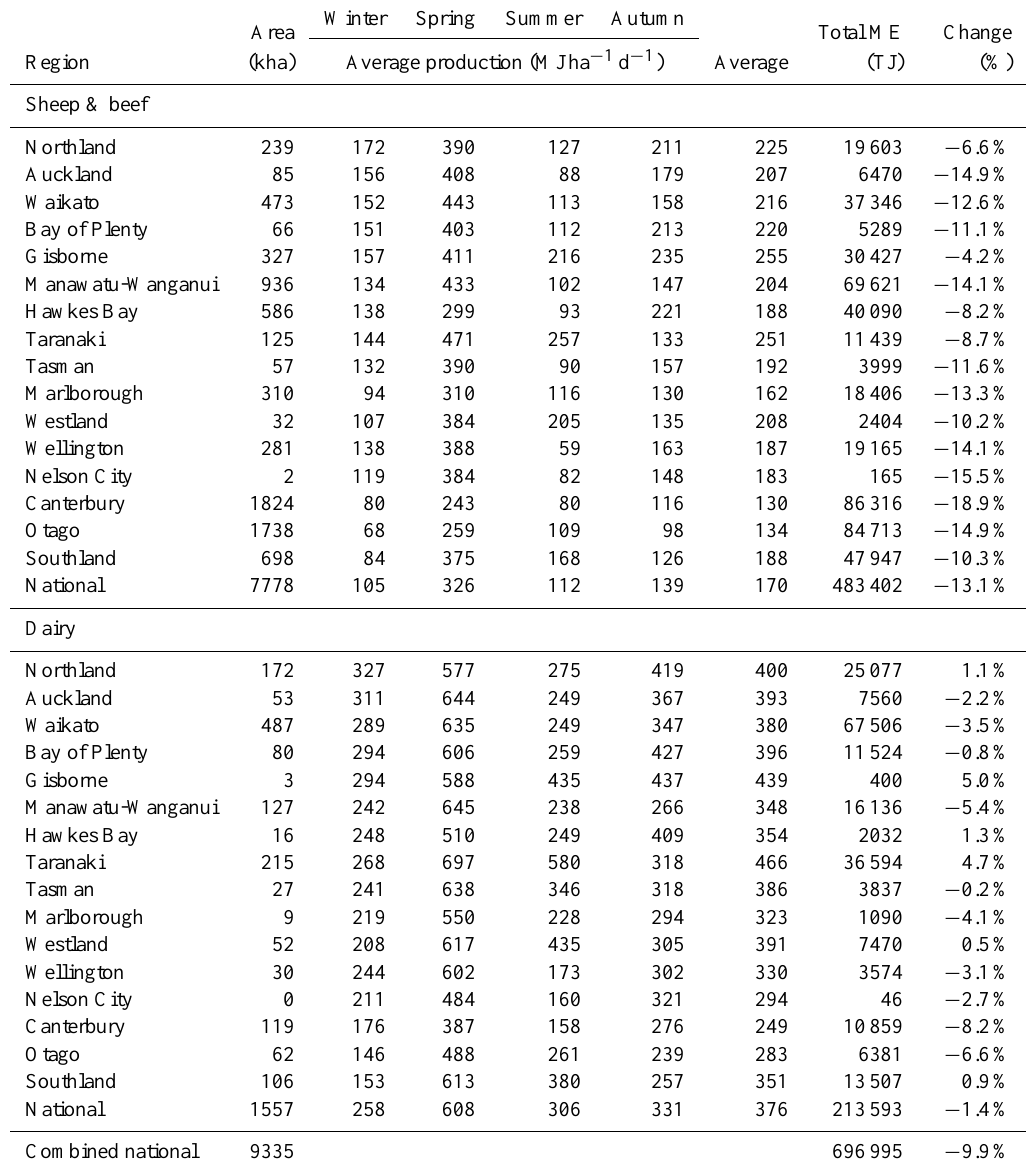
Table B7. Climate change 2100 (CCC model).